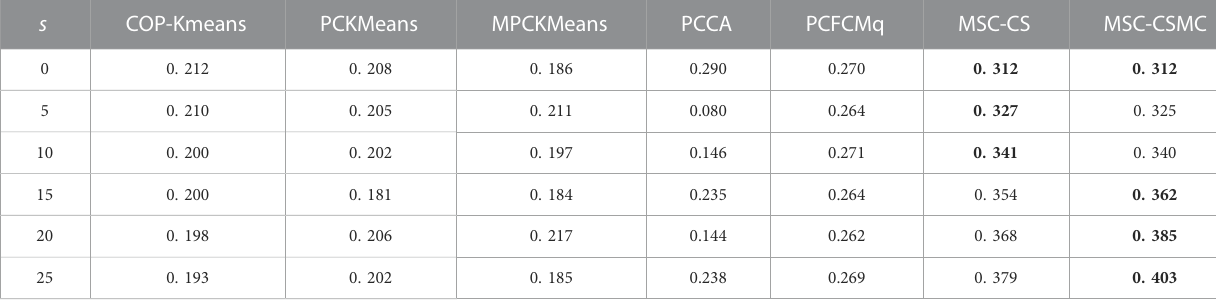
TABLE 5 SI values on Serum with different number of